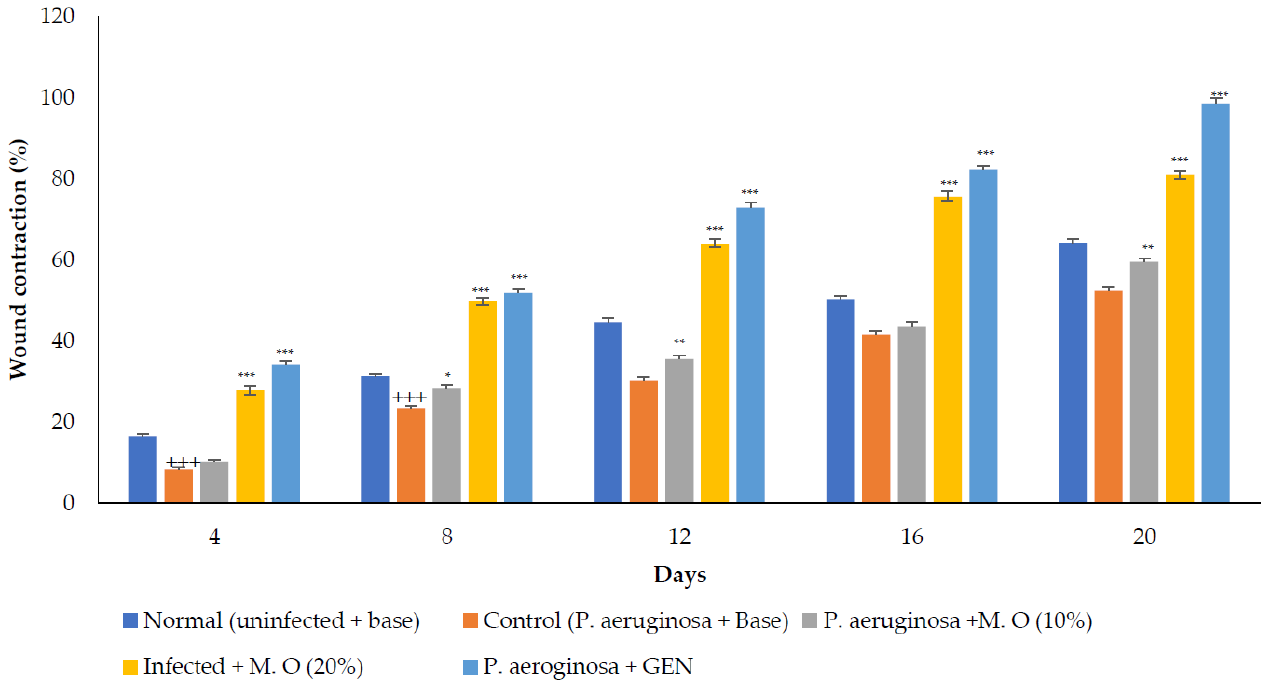
Figure 9. M . oleifera extract ointment preparation on the percentage of wound contraction in P. ae ‐ ruginosa ‐ infected wounds. All values are mean ± SEM, n = 6, +++ p < 0.001 when compared to normal. * p < 0.05, ** p < 0.01, *** p < 0.001 when compared to control.